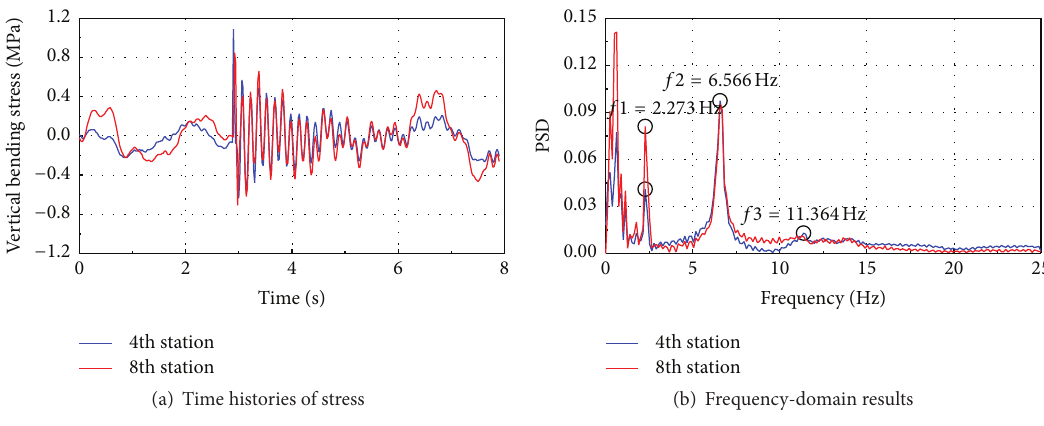
Figure 11: Hammer test of vertical vibrations in wetted